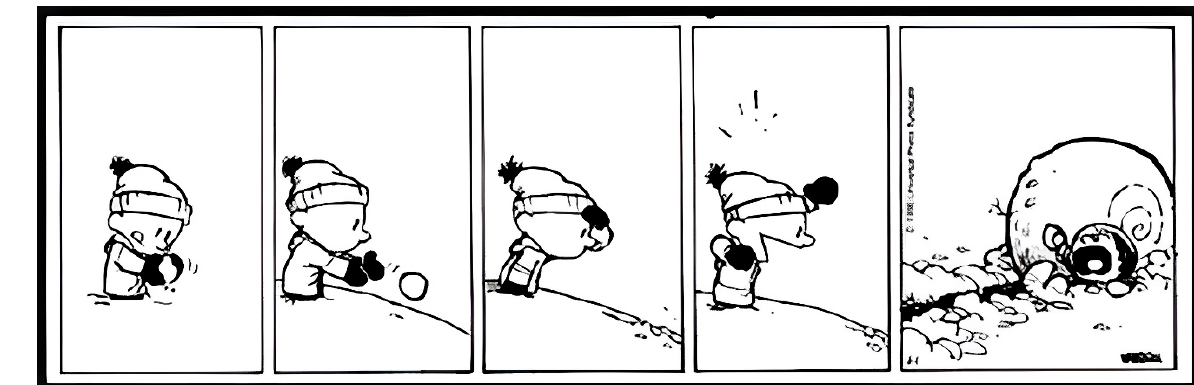
Figure 3. Visual metaphor of the “compound interest” concept. Source: www.medium.com. Available online: http://bit.ly/3HcxYvI (archived on 23 January 2023).